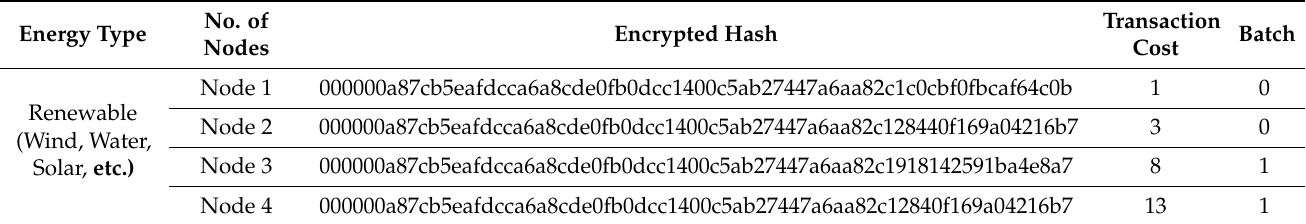
Table 2. Calculated hashes of the encrypted nodes and the relation between cost of node transaction. Energy